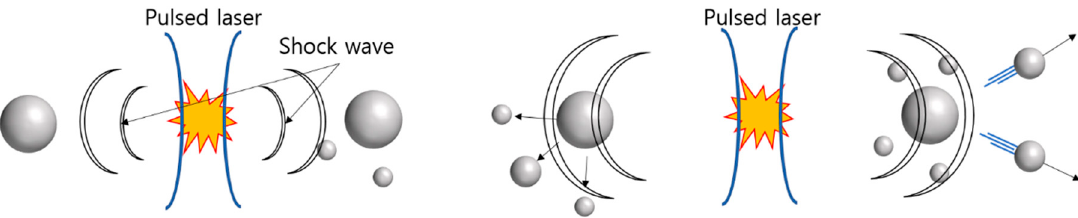
Figure 2. Effect of shockwave propagation on laser fragmentation.